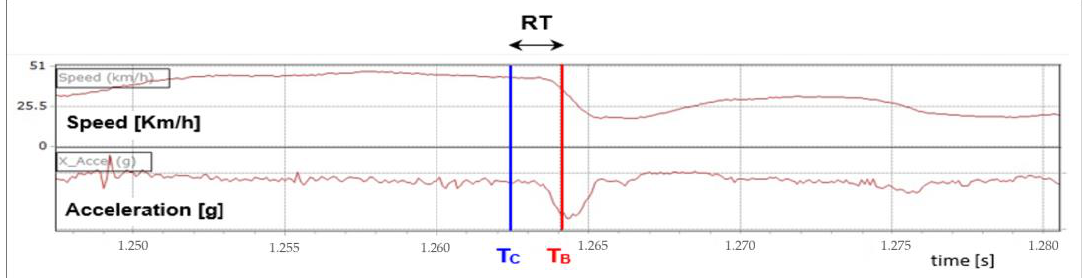
Figure 5. Evaluation of the Reaction Time (RT).